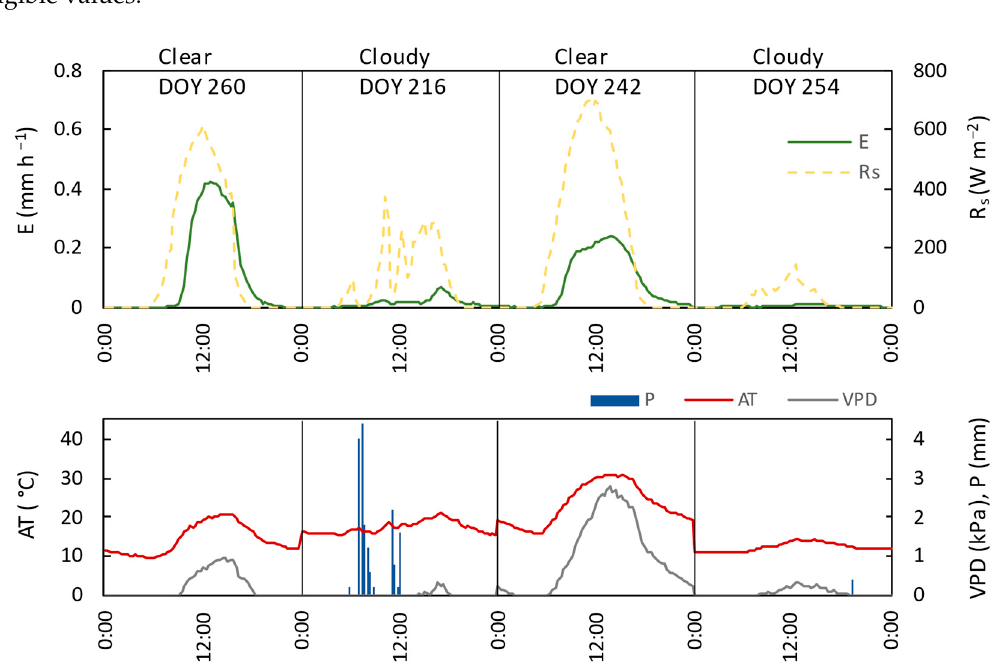
Figure 7. Diurnal dynamics of transpiration ( E , 20 ‐ min data) and global radiation ( R S ), air temperature ( AT ), vapour pressure deficit ( VPD ) and precipitation ( P ) during sunny/clear days and cloudy days in period without soil water deficit ( left , DOY 260 and 216) and with soil water deficit ( right , DOY 242 and 254). The data are provided in Central European Time (UTC+1).